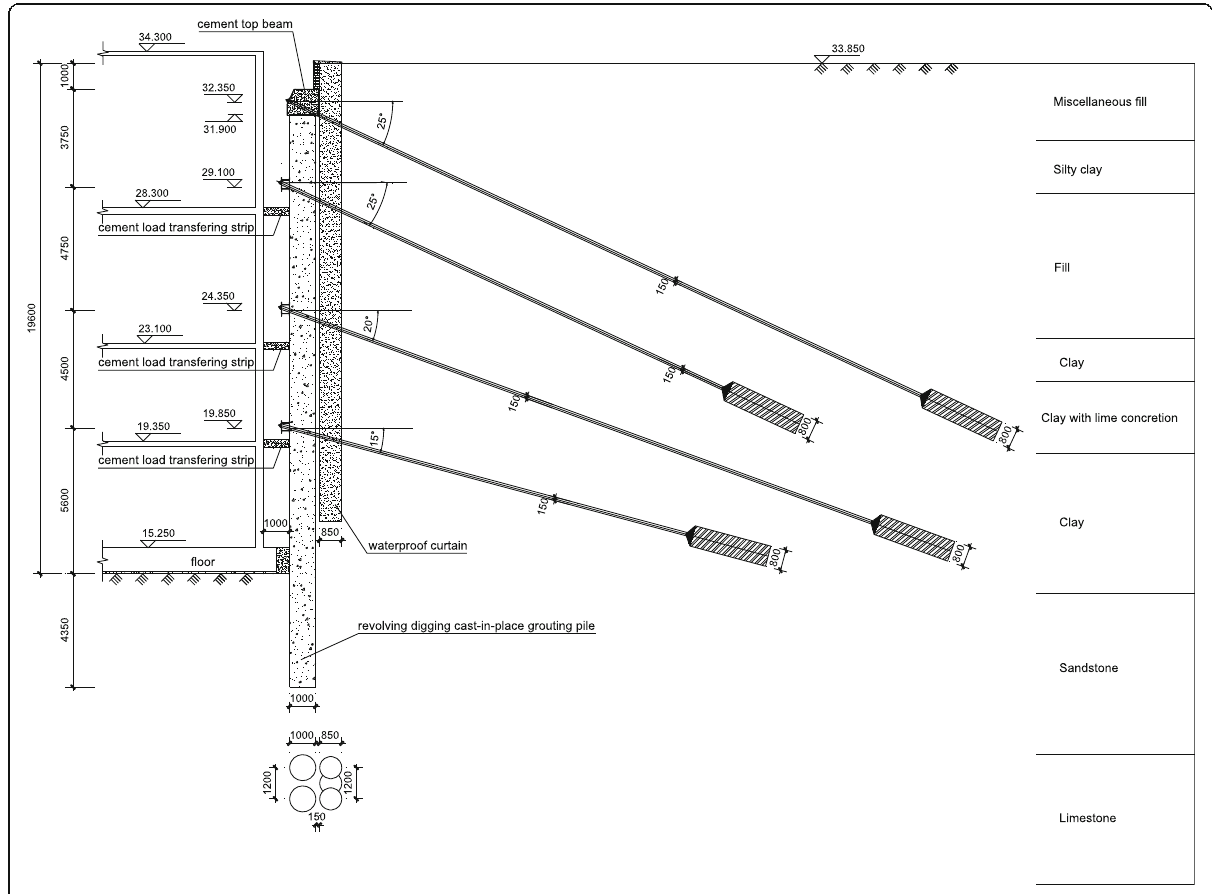
Table 2 Parameters of anchor cables Layer Horizontal interval (m)